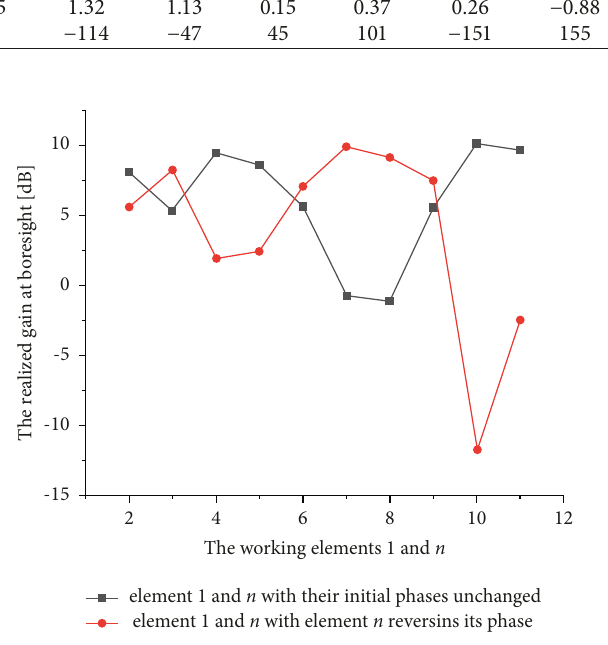
Figure 6: The realized gain of element 1 and element Table 3: The excitations of all elements after adjustment.